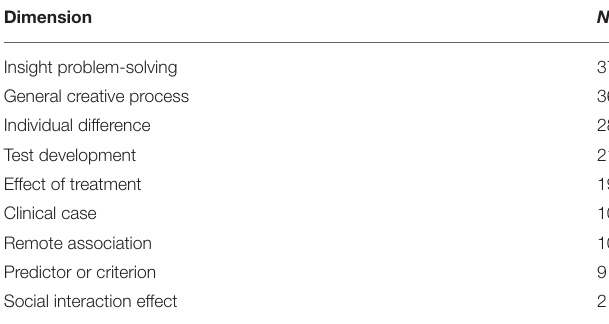
TABLE 3 | The number of the studies for each